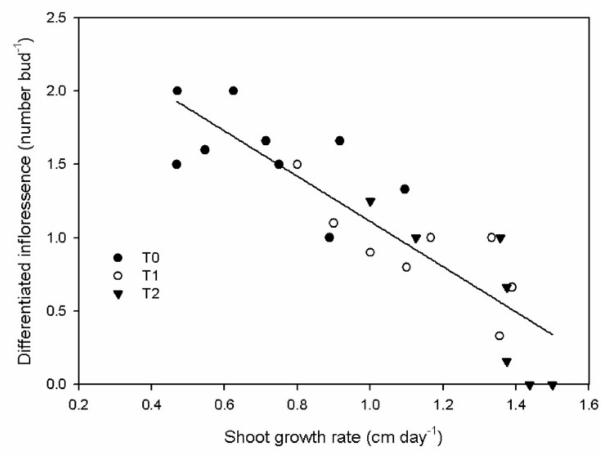
Figure 9. Mean bud fruitfulness on the 5 basal nodes vs. shoot growth rate from budburst to the appearance of the 5th nodes ( Differentiate inflorescence = − 1.54 × shoot growth rate + 2.65, R 2 = 0.76, p < 0.0001). Each point represents one shoot.